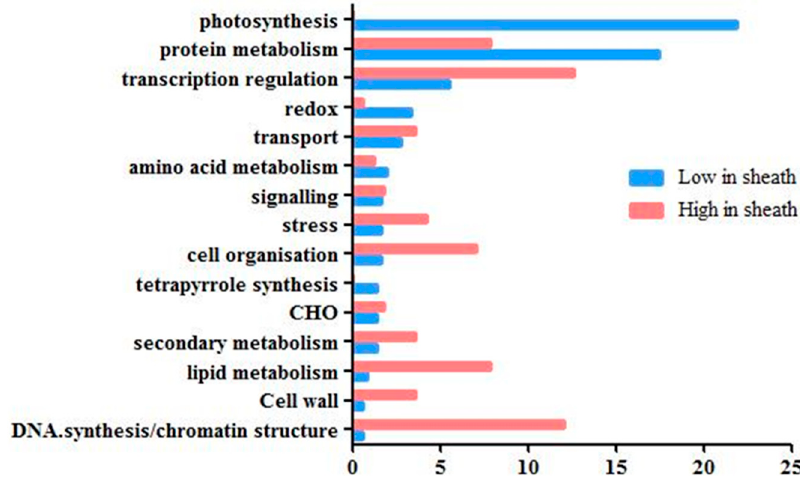
Figure 5. Functional category distribution of genes expressed at high or low levels in the sheath tissue.